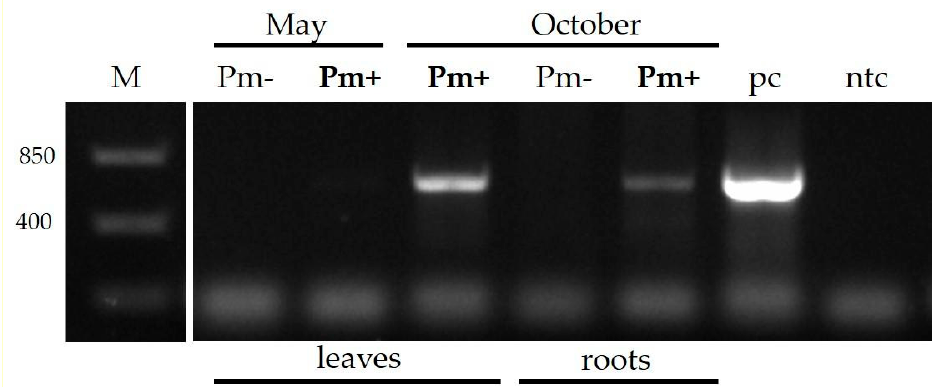
Figure 1. Results of the in silico analysis. Sequence analysis of atp_00136 revealed the presence of an N -terminal signal peptide (indicated in red), as well as a nuclear localization signal (NLS), and a C-terminal nuclear export signal (NES), both indicated in green. Graphs were generated with Geneious Prime 2018 version 11.1.4.